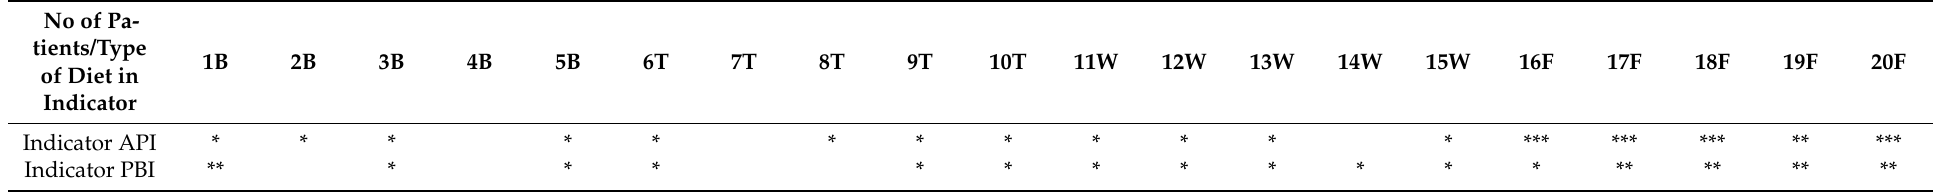
Table 4. Statistical analysis of all 20 analyzed patients with different type of diet after application of API I PBI indicator p < 0.05 *, <0.01 **, <0.001 ***. (see Section 2.4 in Materials and